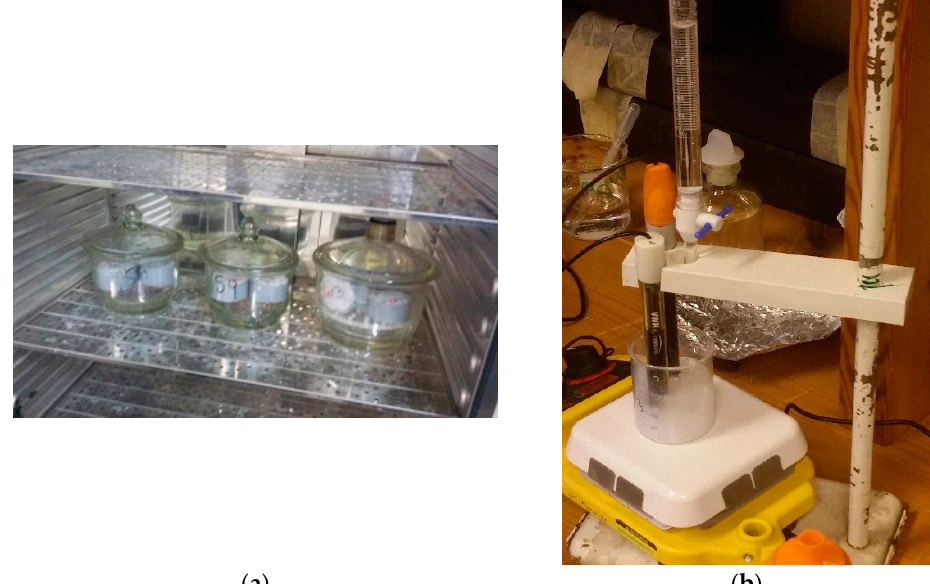
Figure 1. Experimental steps for bound chloride ( a ) samples’ conditioning and ( b ) potentiometric titration setup.